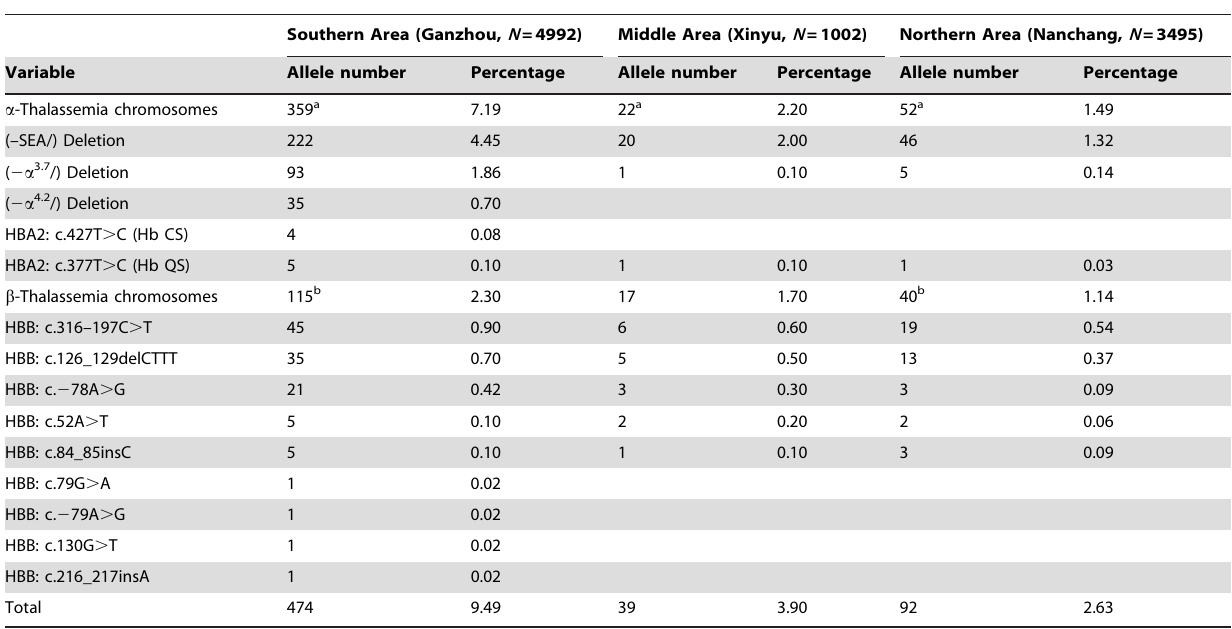
Table 2. a -, b -thalassaemia alleles and their distribution among the three regions in Jiangxi province.